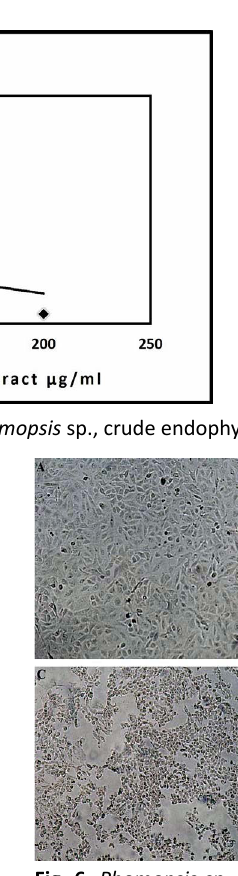
Fig. 3. Phomopsis sp., (A) Vero cell control, (B) Vero cells after 24 hours, (C) Vero cells after 48 hours, (D) Vero cells after 72 hours.